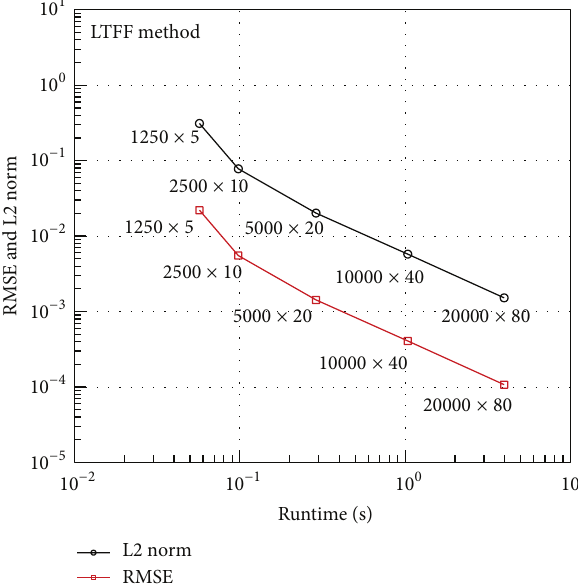
Figure 6: Comparison of RMSE and L2 norm with LTFF method in the solution.